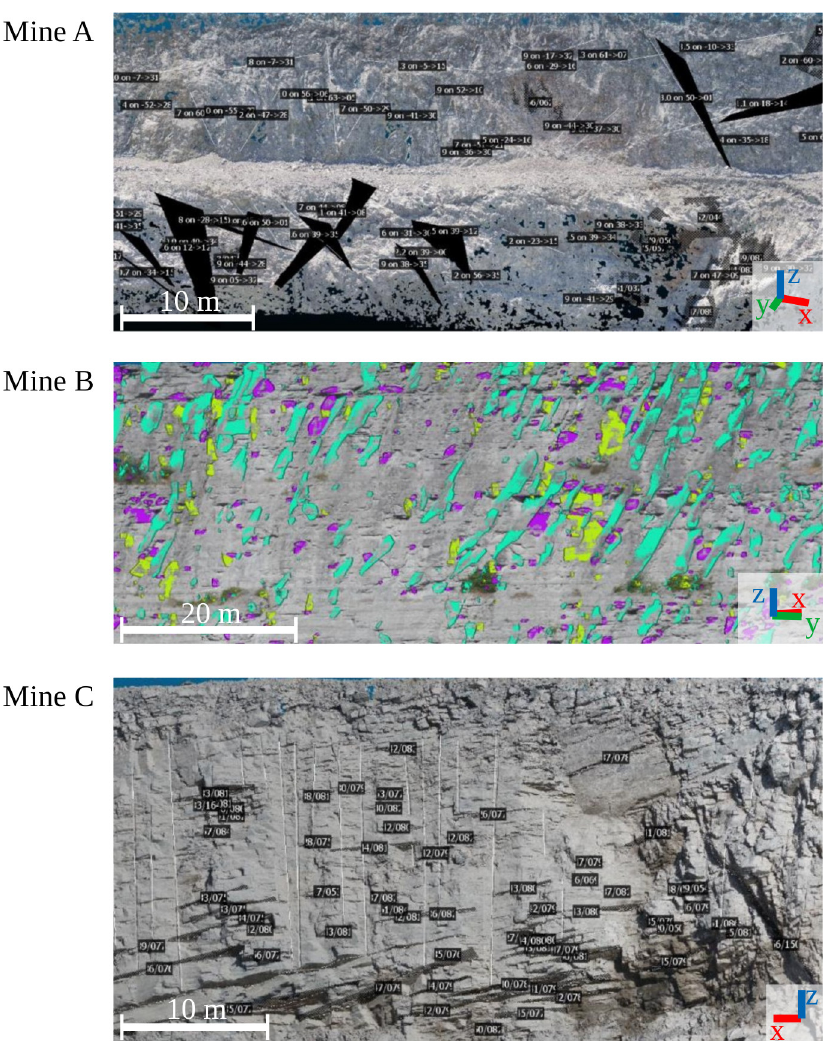
Figure 2. Example of pit wall mapping using a UAV for Mine A (manual virtual mapping), Mine B (automated virtual mapping) and Mine C (semi-automated virtual